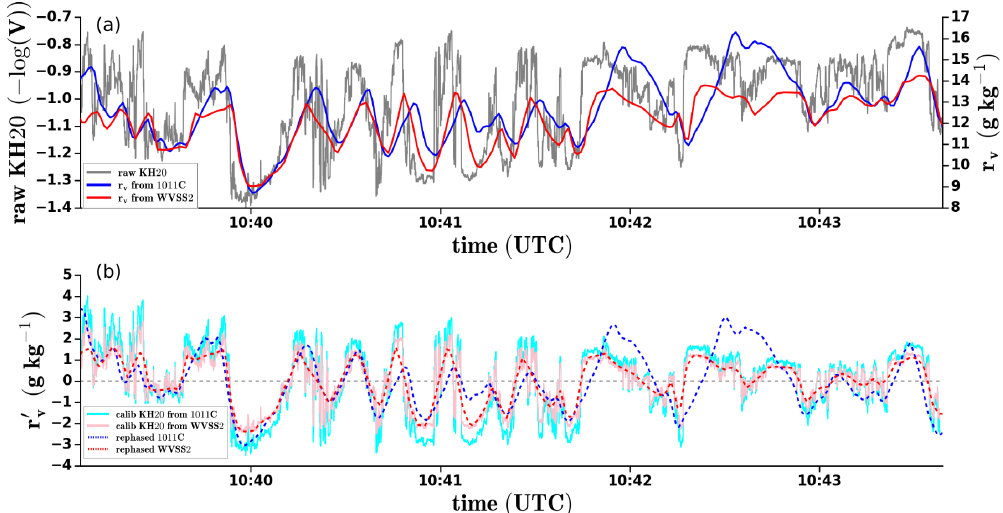
Figure 3. Same as Fig. 2 for a leg (l1c) flown at z ∼ 600m on 13 February 2020 (RF19).